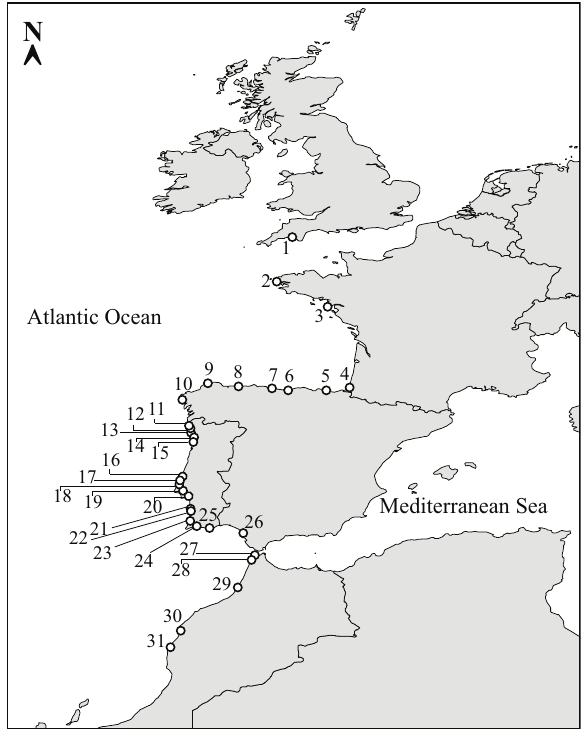
Fig . 1. – Map of sampling localities: 1, Wenbury; 2, Landuvez; 3, Croisic; 4, Biarritz; 5, San Juan de Gastelugatxe; 6, San Vicente de la Barquera; 7, Ribadesella; 8, La Caridad; 9, Espasante; 10, Toriñan; 11, Moledo do Minho; 12, Vila Praia de Âncora; 13, Viana do Castelo; 14, Vila do Conde; 15, Mindelo; 16, Baleal; 17, São Bernardino; 18, Santa Cruz; 19, Praia das Avencas; 20, Portinho da Arrábida; 21, Queimado; 22, Oliveirinha; 23, Castelejo; 24, Porto de Mós; 25, Olhos d’Água; 26, Chipiona; 27, Ksar-es-Seghir; 28, Cap Malabata; 29, Assilah; 30, Rabat; 31, Essaouira